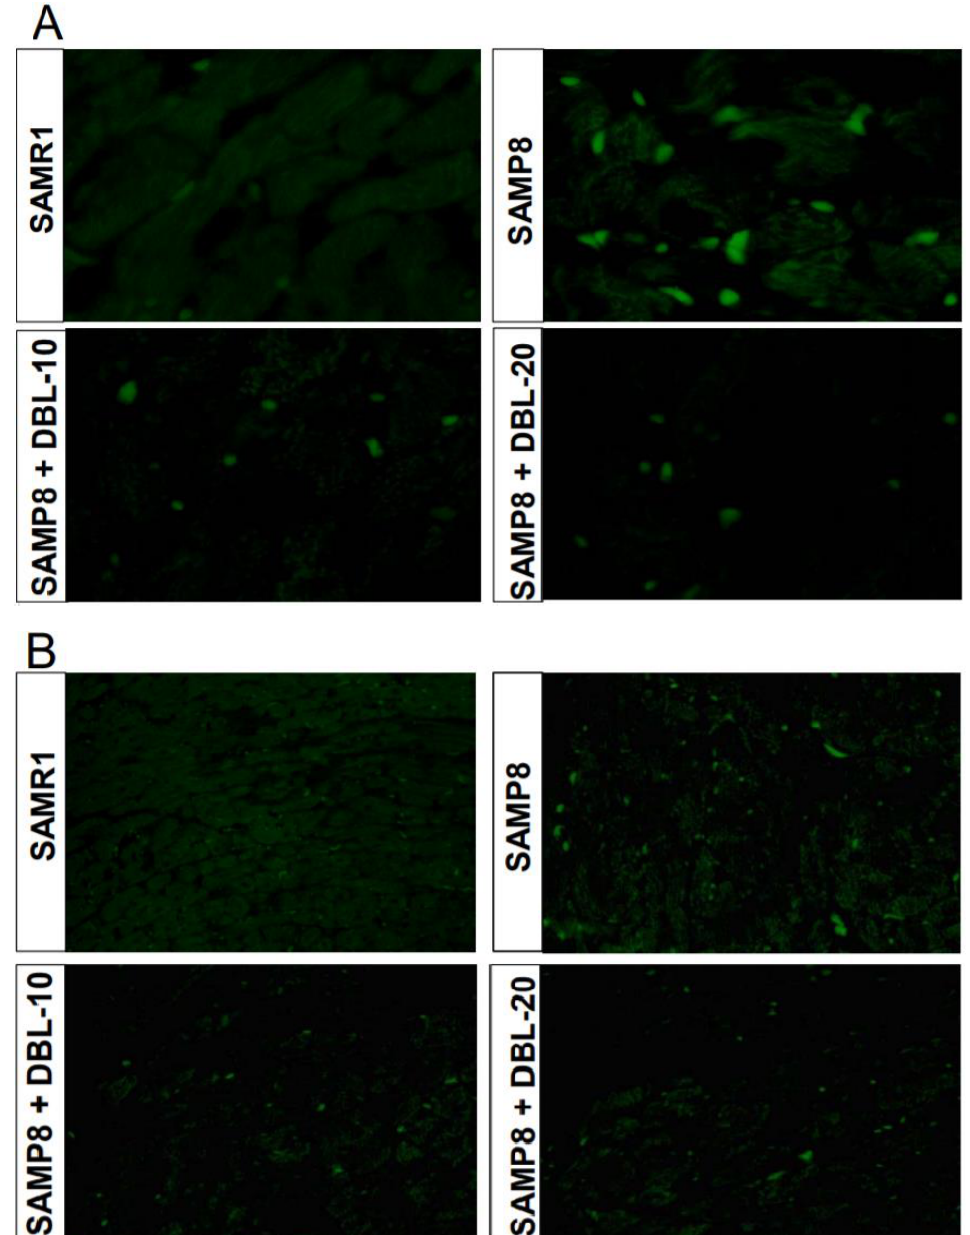
Figure 3. The treatment with DBL inhibits aging-mediated caspase-3 positive cells and cardiac apoptosis. ( A ). The representative photomicrographs of heart sections show the caspase-3 immunofluorescence identified by immunohistochemical staining with anti-caspase-3 antibodies at 400× magnification. ( B ). The representative photomicrographs show myocardial tissue sections terminal transferase-mediated dUTP nick end labeling (TUNEL)-stained for the detection of apoptotic nuclei at 200× magnification.